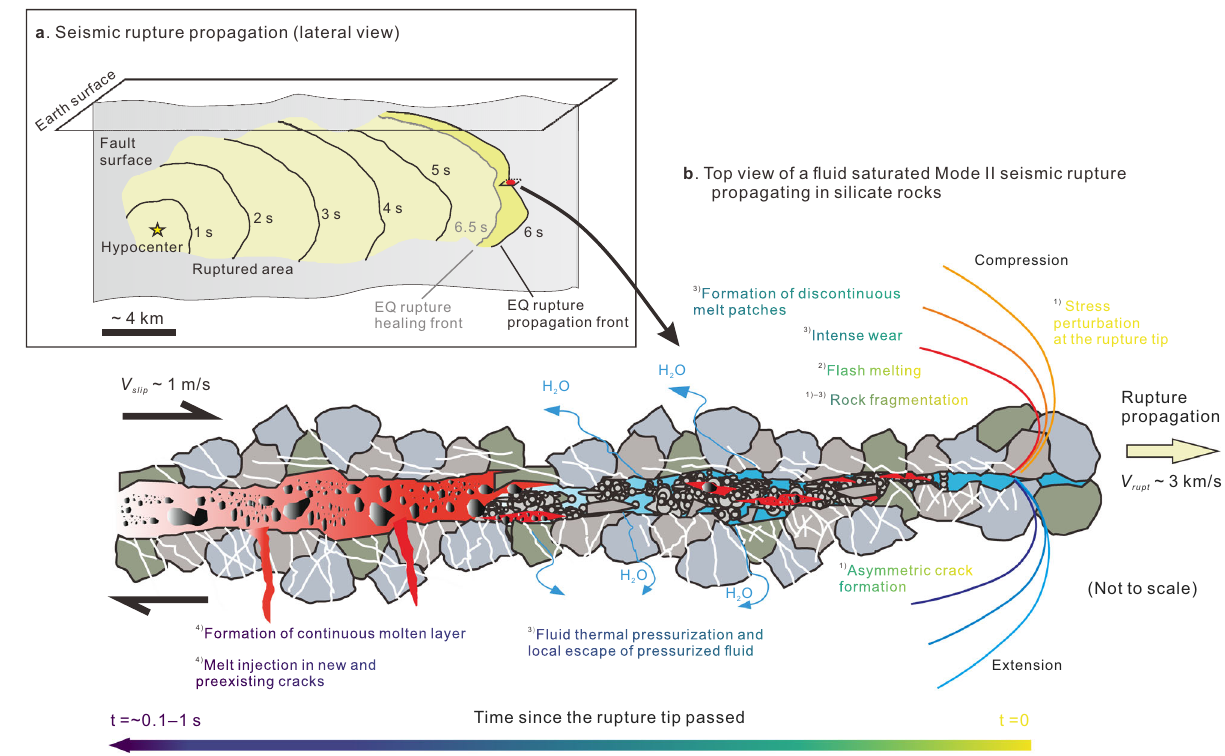
Fig. 1| Conceptualmodelofseismic rupturepropagation. a Earthquake rupture propagationalongafaultasaself-healingpulse. b Seismicslippingzoneatthescale downtomicronswiththesequenceofdeformationeventstriggeredbythepassage of the rupture propagation front and frictional heating at its wake in a fl uid-